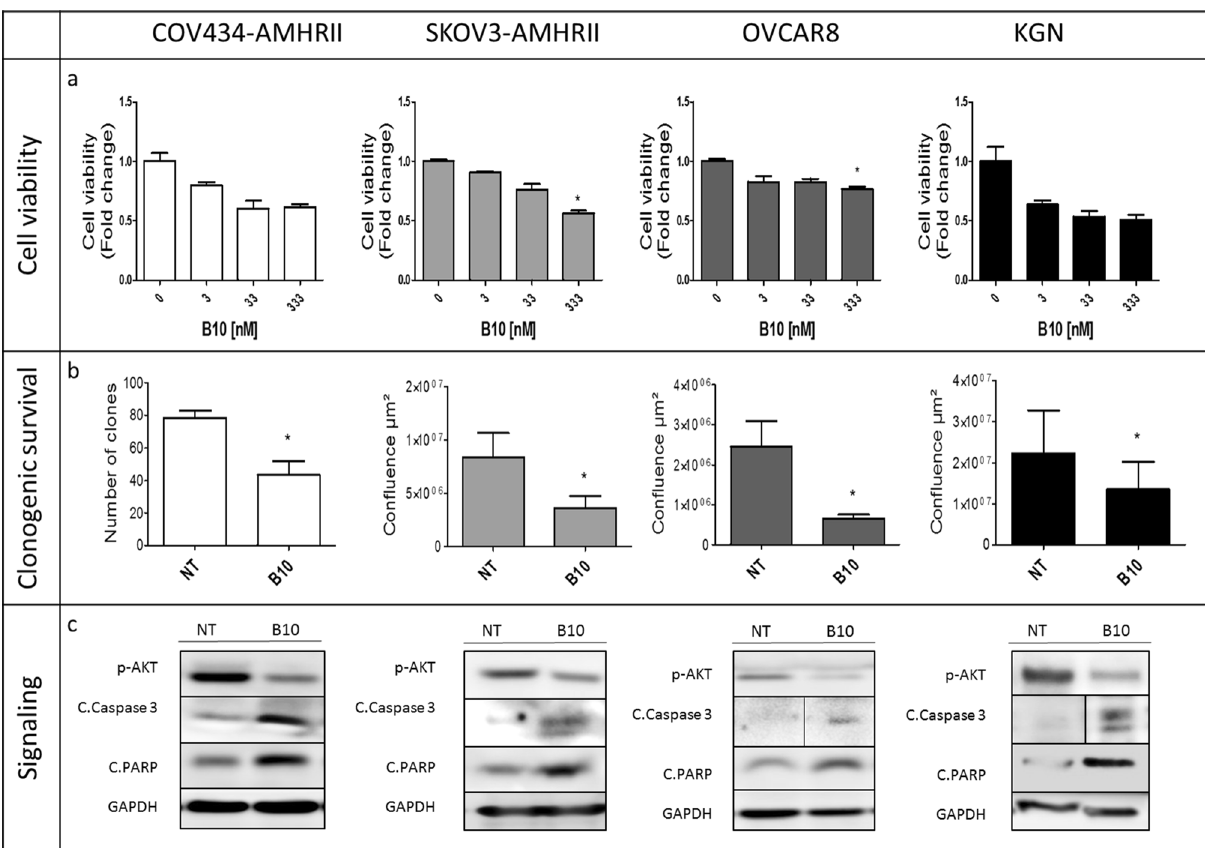
Figure 2. The anti-AMH antibody B10 reduces cell viability/proliferation and induces growth inhibition in COV434-AMHRII, SKOV3-AMHRII, OVCAR8, and KGN cells. ( a ) Cell viability was analyzed (MTS assay) after incubation with 3 to 333 nM B10 for 3 days. ( b ) Clonogenic survival in COV434-AMHRII cells (direct clone counting) and in SKOV3-AMHRII, OVCAR8, and KGN cells (measurement of cell confluence using the Celigo Imaging System) after incubation or not with 70 nM B10 for 11 days. ( c ) AKT phosphorylation and apoptosis induction (cleaved caspase 3 and PARP) after incubation or not with 333 nM B10 for 24 h. All proteins were analyzed on the same gel and membrane. After blotting, the lines corresponding to the different proteins were cut and may have been exposed for different lengths of time because the objective was not to compare the different proteins with each other, but to see the effect of B10 on the expression of each protein. Figure shows a representative experiment out of 2 to 4 experiments performed depending on the cell line (mean ± SEM of 3 replicate wells) *p <